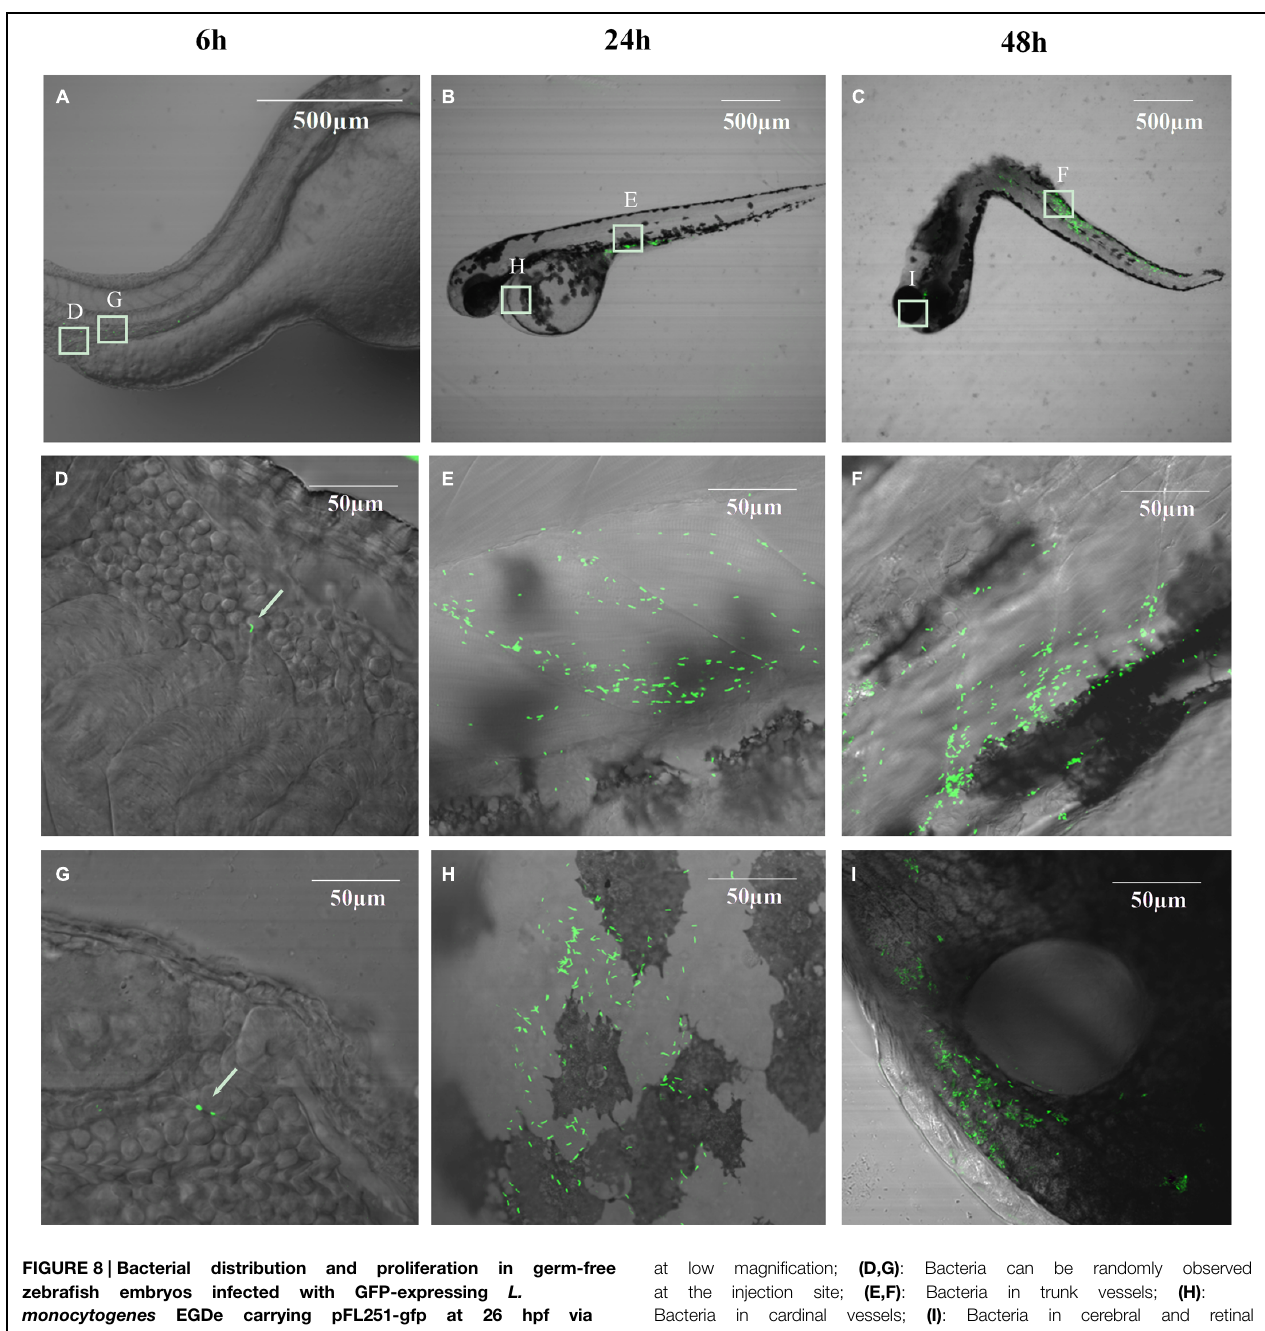
at low magnification; (D,G) : Bacteria can be randomly observed at the injection site; (E,F) : Bacteria in trunk vessels; (H) : Bacteria in cardinal vessels; (I) : Bacteria in cerebral and retinal